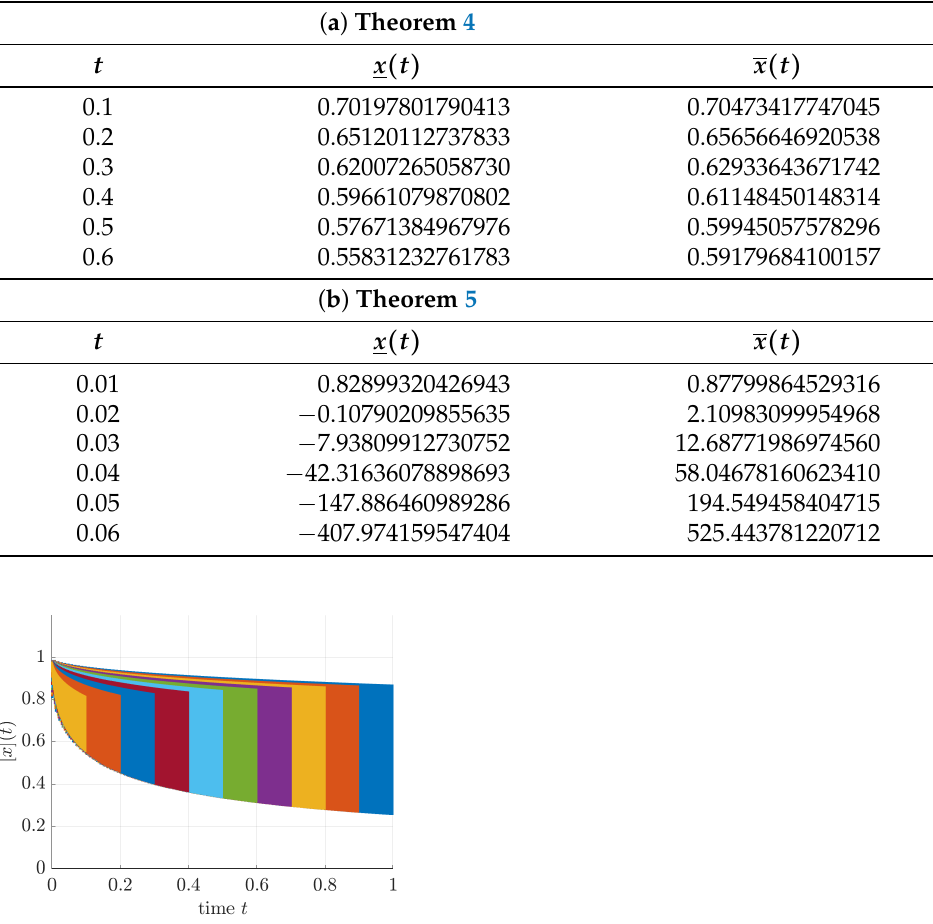
Table 4. Comparison of Theorems 4 and 5 for the example (39).